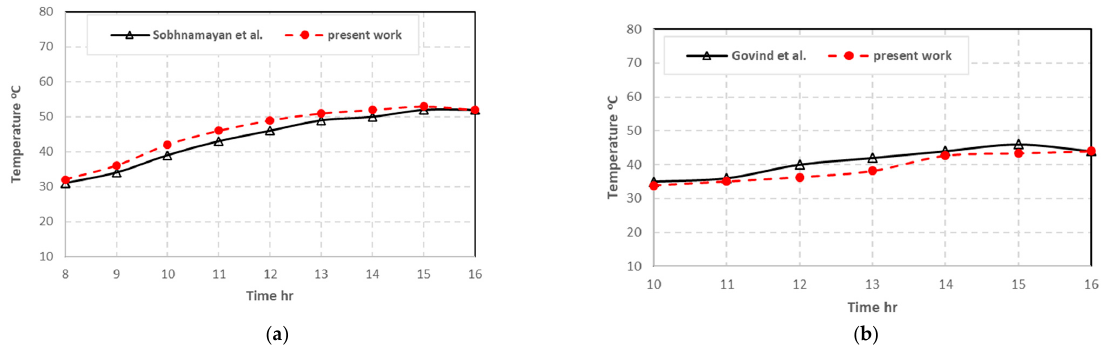
Figure 10. Hourly variations in outlet water temperature ( a ) for present model and [40] ( b ) for present model and [41].